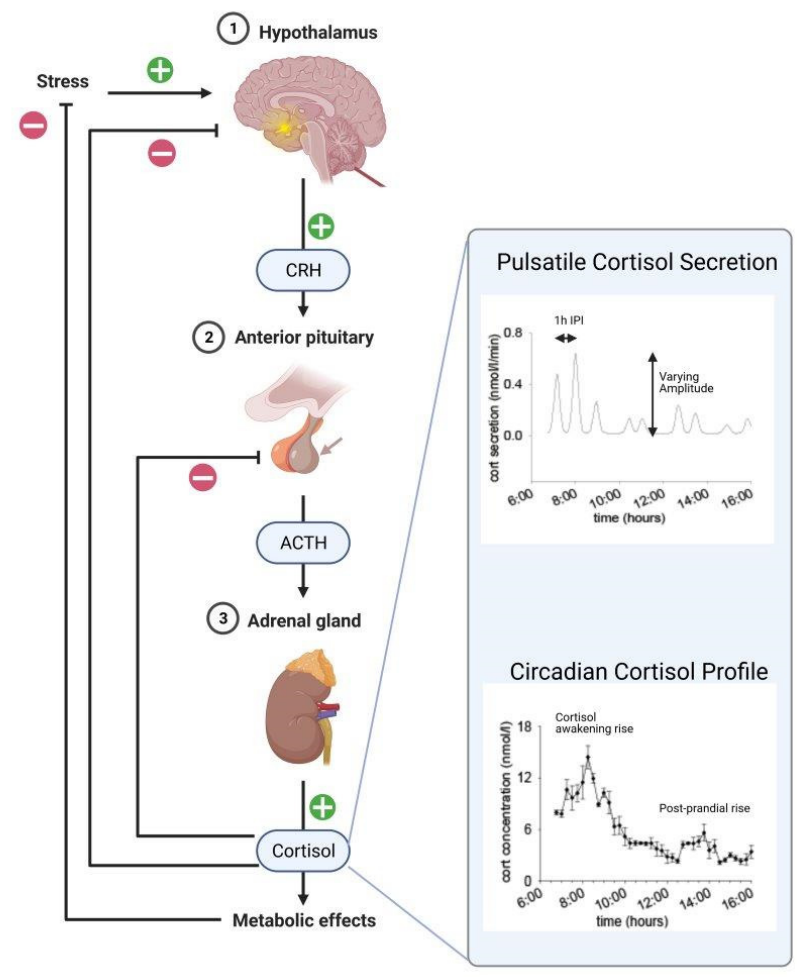
Figure 1. The hypothalamus–pituitary–adrenal (HPA) axis controls both ultradian and circadian cortisol rhythms to generate metabolic effects that help the body combat stress and re-establish homeostasis post stress. Pulsatile cortisol profiles adapted from [37].